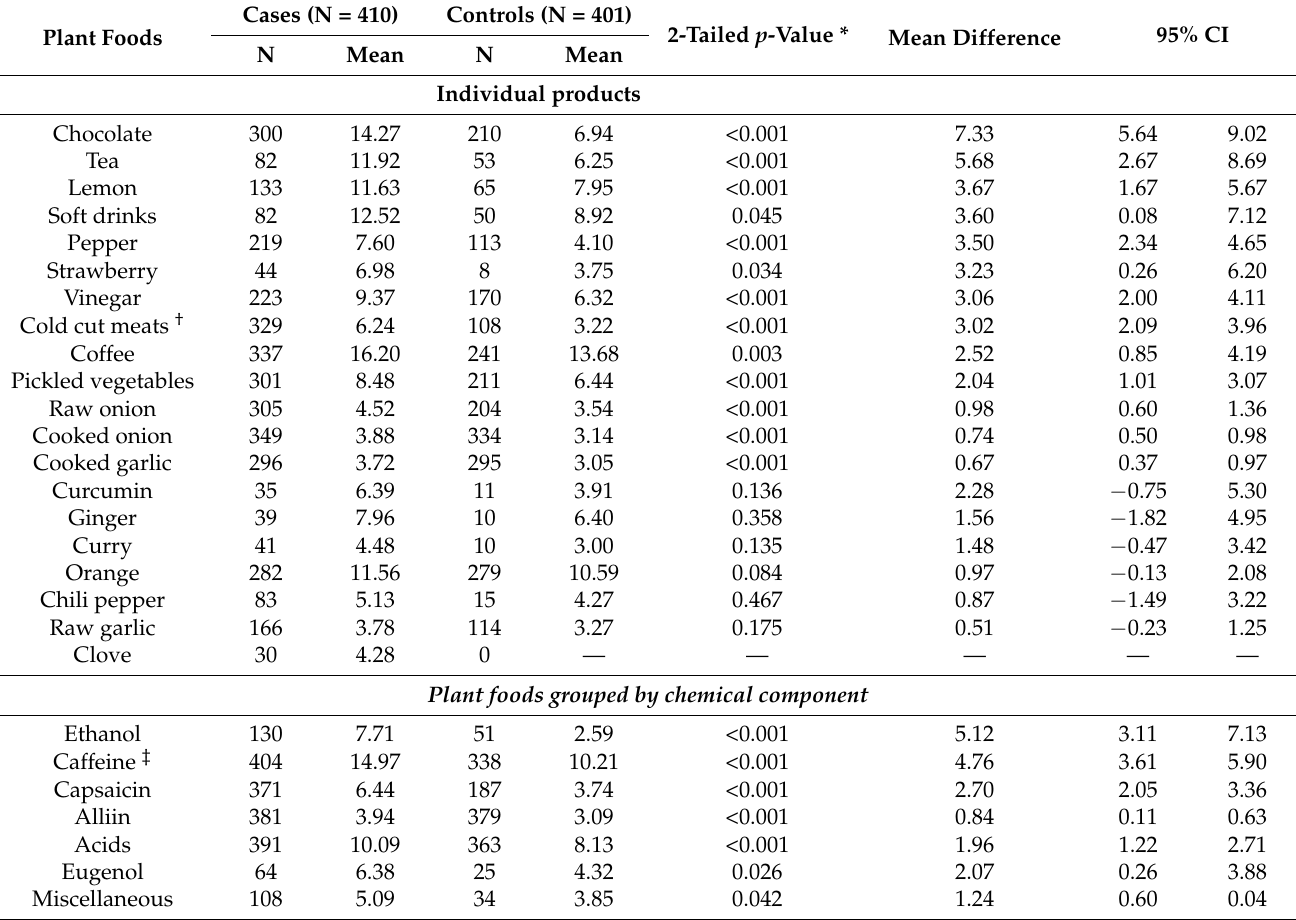
Table 3. Mean intake and frequency for individual food products and plant food categories by study group.